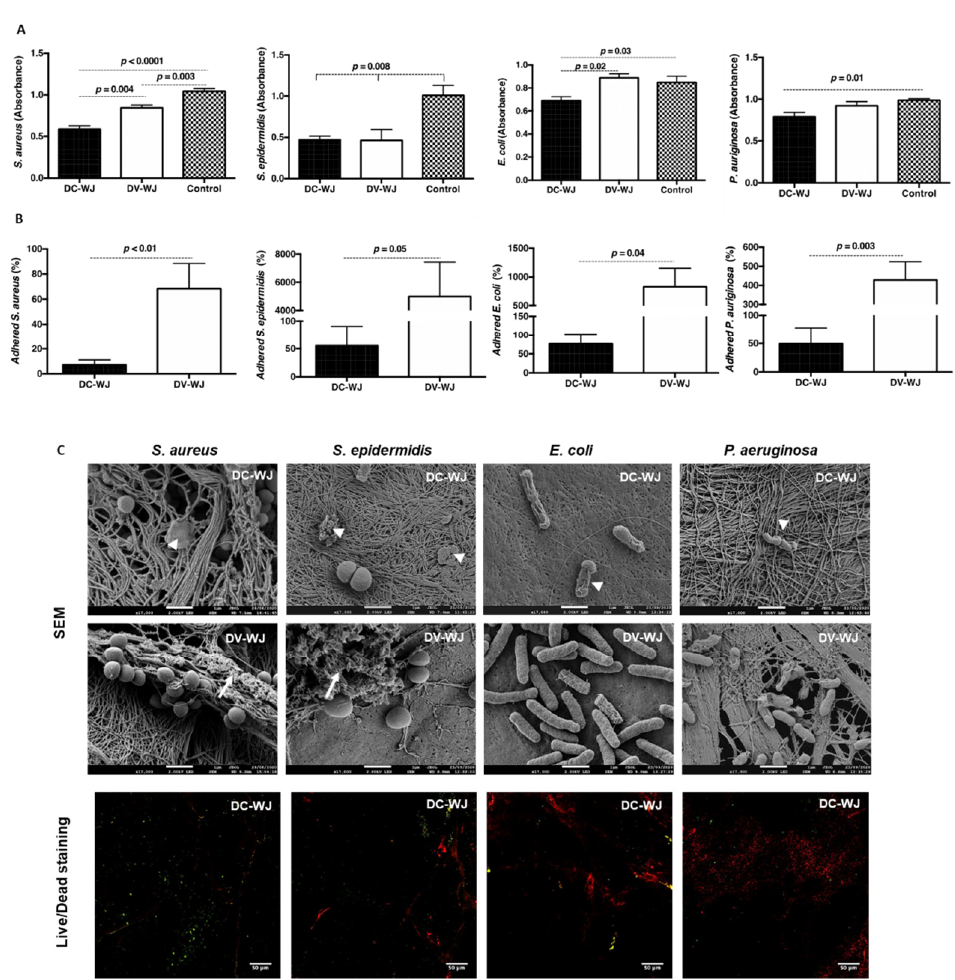
Figure 3. Antibacterial properties of decellularized and devitalized Wharton’s Jelly. ( A ): planktonic growth of bacteria in the presence of DC-WJ and DV-WJ. ( B ): Adhered bacteria on DC-WJ and DV-WJ. ( n = 9, Wilcoxon-Mann-Whitney test). ( C ): Scanning electron microscopy pictures of bacteria adhered on DC-WJ (upper line) and on DV-WJ (middle line). Head arrows indicate damaged bacteria and full arrows indicate biofilm-like matrix (scale bars = 1 µm). Confocal observations of adhered bacteria on DC-WJ (lower line), in red dead bacteria and in green alive bacteria (scale bars = 50 µm).